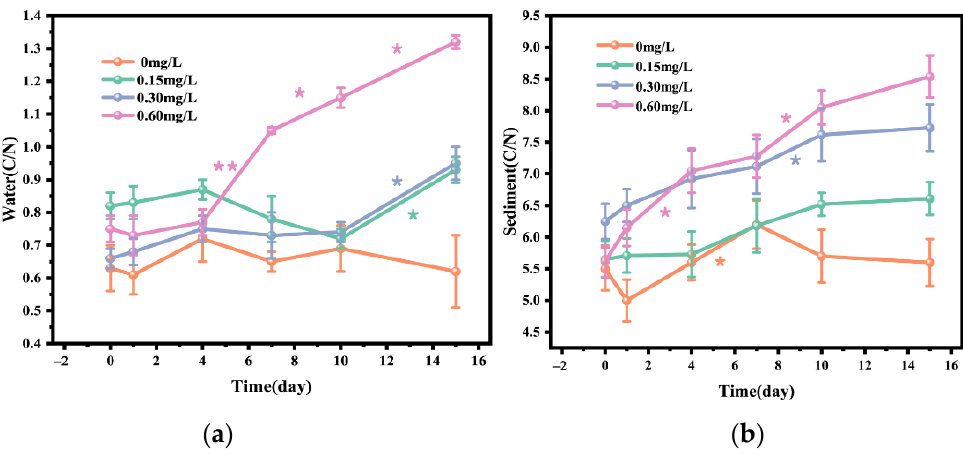
Figure 4. C/N ratio in water ( a ) and C/N ratio in sediment ( b ) after addition of different concentra- tions of nitrifying and denitrifying bacteria. The orange “*” indicate significant differences between 0 mg/L groups, the green “*” indicate significant differences between 0.15 mg/L groups, the purple “*” indicate significant differences between 0.30 mg/L groups, and the pink “*” indicate significant differences between 0mg/L groups. (the “ * ” expression p < 0.05, the “ ** ” expression p < 0.01).